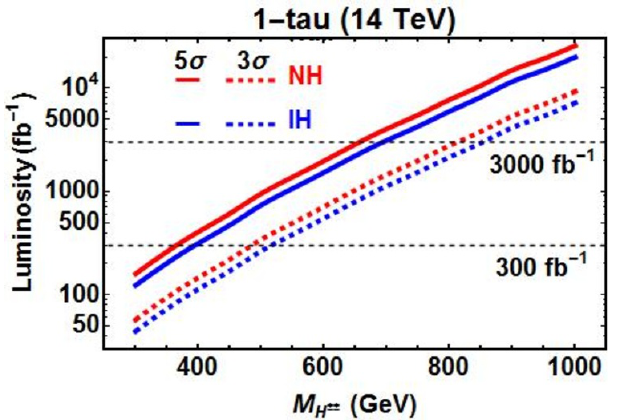
Figure 6 . Integrated luminosity versus M at 3 (cid:27) and 5 (cid:27) signi(cid:12)cance for pp ! H ++ H (cid:0)(cid:0) ! H (cid:6)(cid:6) ( (cid:0) ) (cid:28) (cid:6) ‘ (cid:6) ‘ (cid:7) ‘ (cid:7) with (cid:28) (cid:6) ! (cid:25) (cid:6) (cid:23) (cid:28) for NH and IH at 14 TeV LHC. HE-LHC and FCC-hh is above 525 (975) GeV and 960 (1930) GeV respectively, for the luminosity of 300 (3000) fb (cid:0) 1 . The accessible mass for 2 (cid:28) channel is much lower than 1 (cid:28) channel, e.g. 300{400 GeV at HE-LHC and 600{800 GeV at